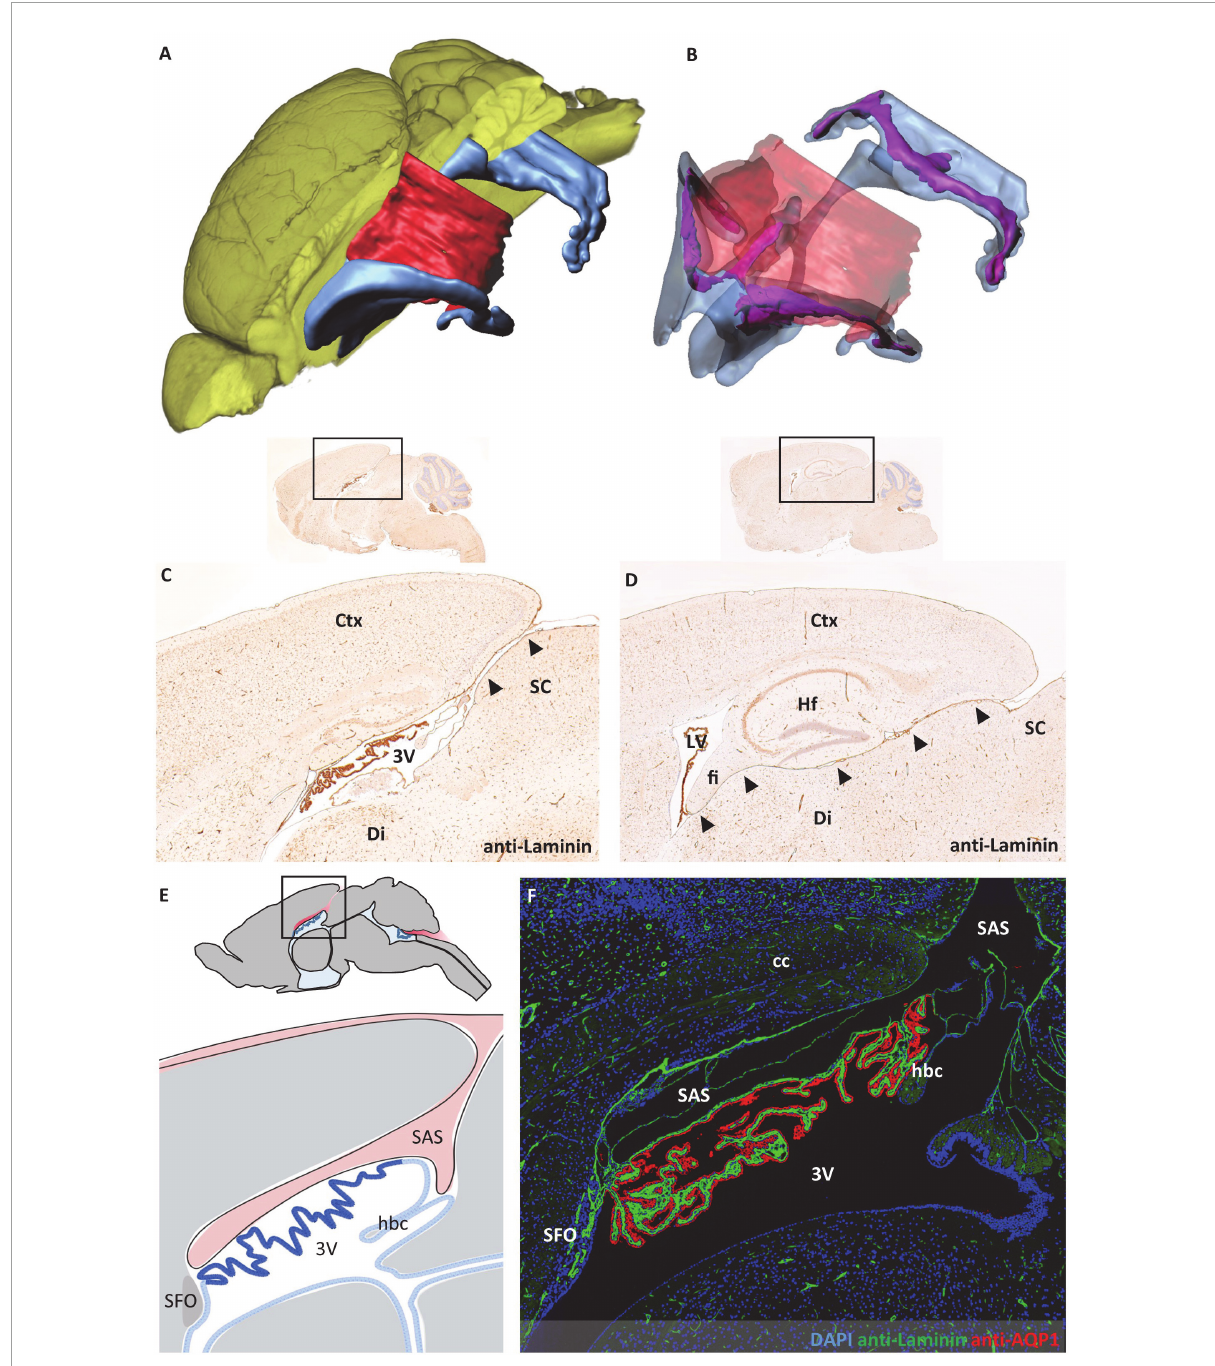
FIGURE6 Relationship between subarachnoid space and third ventricle. The subarachnoid space extends from occipitally beneath the cortex and rostrally above the third ventricle. (A) Volume rendering of the brain (yellow) with surface models of the ventricular system (blue) and subarachnoid space (red) to illustrate their spatial relation. (B) Transparent representation of the subarachnoid space and the ventricular system show the choroid plexus (purple) in the ventricular lumen. (C,D) Sagittal sections with immunohistochemical labeling with anti-laminin and faint hemalum counterstaining depict the connection of the subarachnoid space and the roof of the third ventricle in the mediosagittal plane in (C) (arrowheads) and the connection of the subarachnoid space and the lateral ventricle in a lateral sectional plane in (D) (arrowheads). (E) Schematic of the median region in sagittal orientation, the subarachnoid space (red) is in contact with the ventricular system above the third ventricle. Created with BioRender.com. (F) Immunofluorescence double labeling with anti-laminin (green), anti-aquaporin1 (AQP1, red), and nuclear staining with 4 (cid:48) ,6-diamidino-2-phenylindole (DAPI, blue) of the same region as shown in (E) . 3V third ventricle, cc corpus callosum, Ctx, cortex; Di, diencephalon; fi, hippocampal fimbria; hbc, habenular commissure; Hf, hippocampal formation; LV, lateral ventricle; SC, superior colliculus; SAS, subarachnoid space; SFO, subfornical